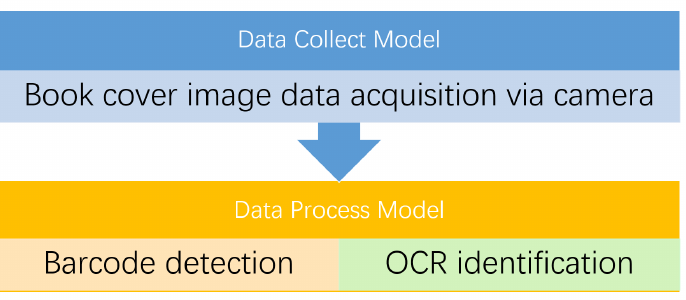
Figure 5. The architecture of smart book sorting system